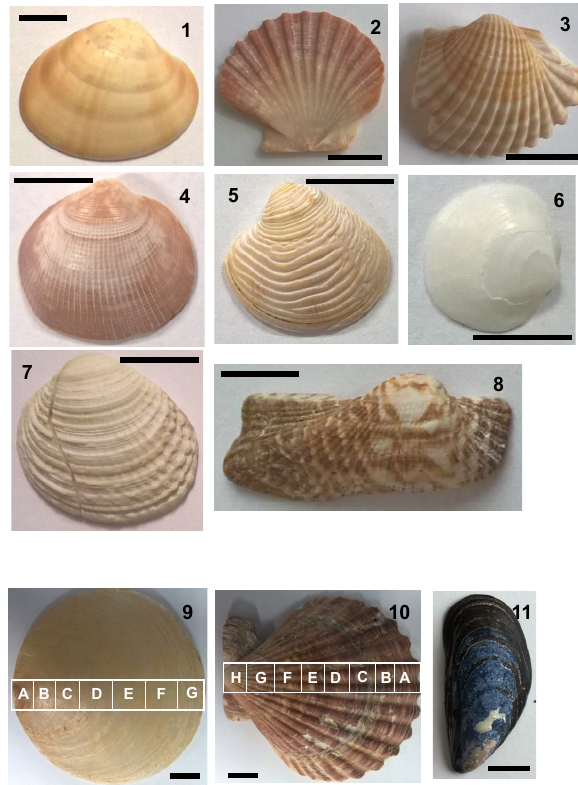
Figure 2. Photographs of representative bivalve species studied herein. (1)–(8) from Playa Poniente, (9) from Kakinada Bay, (10) from Hawke’s Bay, and (11) from Godhavn (Qeqertarsuaq). Black scale bar correspond to 1cm. (1) Cardiidae (unknown species); (2) Pecten jacobaeus ; (3) Challista chione ; (4) Glycymeris glycymeris ; (5) Chamelea striulata ; (6) Loripes lucinalis ; (7) Venus verrucosa ; (8) Arca navicularis ; (9) Placuna placenta (window- pane oyster, Capiz; with growth profile samples indicated); (10) Mi- machlamys townsendi (with growth profile samples indicated) and (11) Mytilus edulis